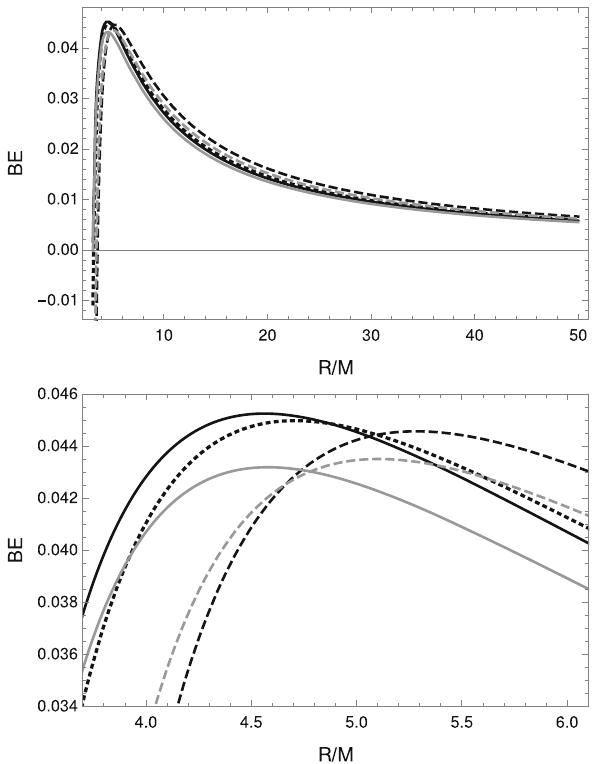
Fig. 4 The fractional binding energy BE as a function of compact- ness parameter R / M . The black/gray lines lines correspond to a phase σ = 1, σ = − 1, respectively. The solid/dashed lines correspond to the outermost inhomogeneity being overdesnity, underdensity, respec- tively. All curves were plotted for n = 1. The thick dotted line represent the homogeneous cluster (model A)